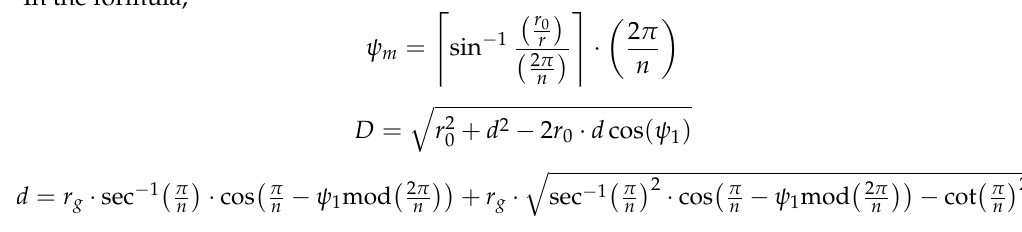
Figure 8. Photon emission in the radial direction in the ionised zone.